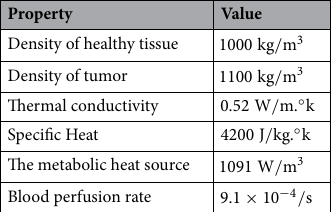
Table 4. Physical properties of skin (used by Sonie et al. 21